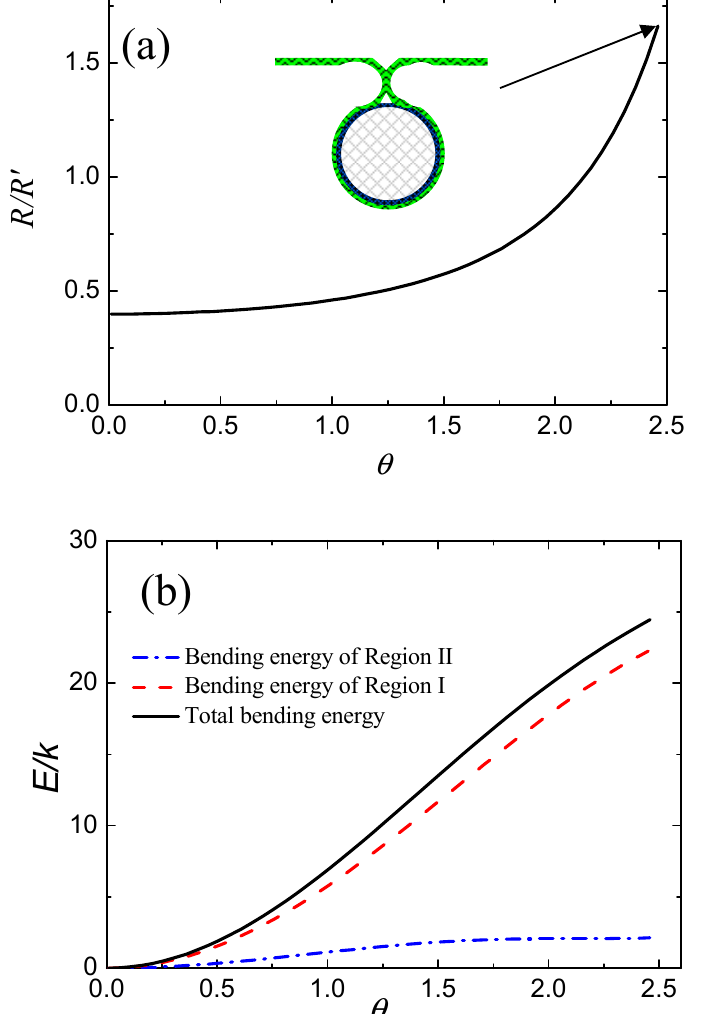
Figure 2. ( a ) The calculated values of R / R (cid:48) as a function of the wrapping degree in the equilibrium state based on Equations (4) and (5). ( b ) The calculated values of total bending energy and partial bending energies of the deformed membrane in Region I and Region II.